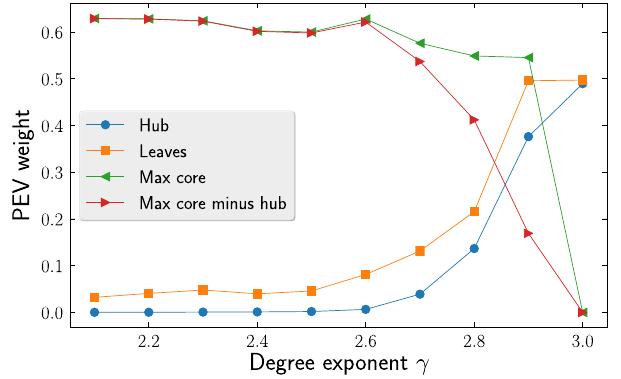
FIG. 9. PEV weight concentrated on various subgraphs for UCM networks of size N ¼ 10 7 with different values of γ .